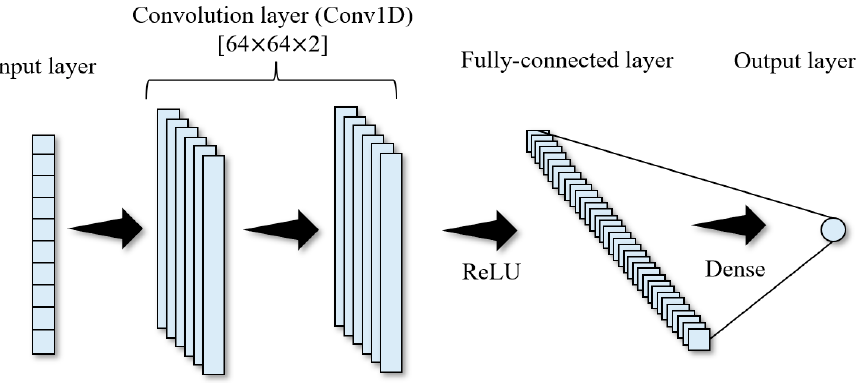
Figure 7. A Descriptive diagram of a CNN.